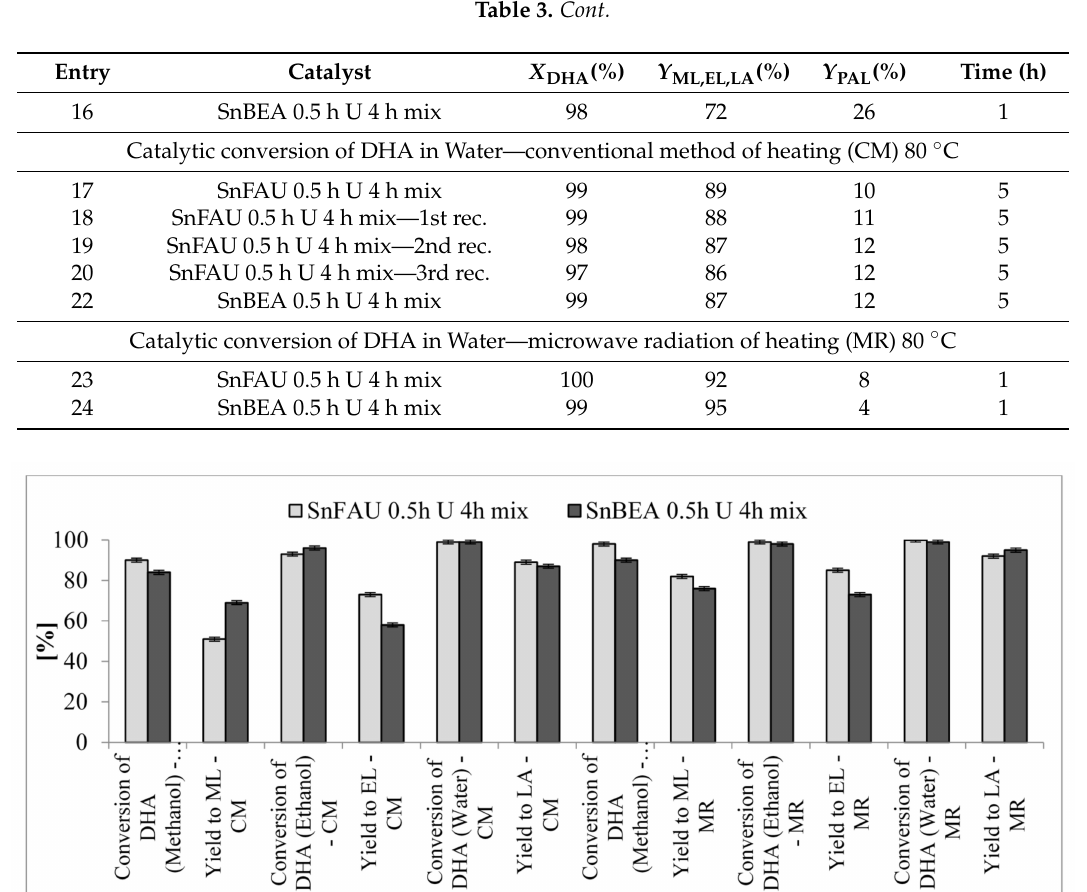
Figure 7. Reaction of DHA isomerization (DHA conversion and conversion yield to the desired reaction product—methyl lactate—ML and ethyl lactate—EL) with the use of SnFAU 0.5 h U 4 h mix and SnBEA 0.5 h U 4 h mix—application of conventional heating method and microwave radiation of heating method.